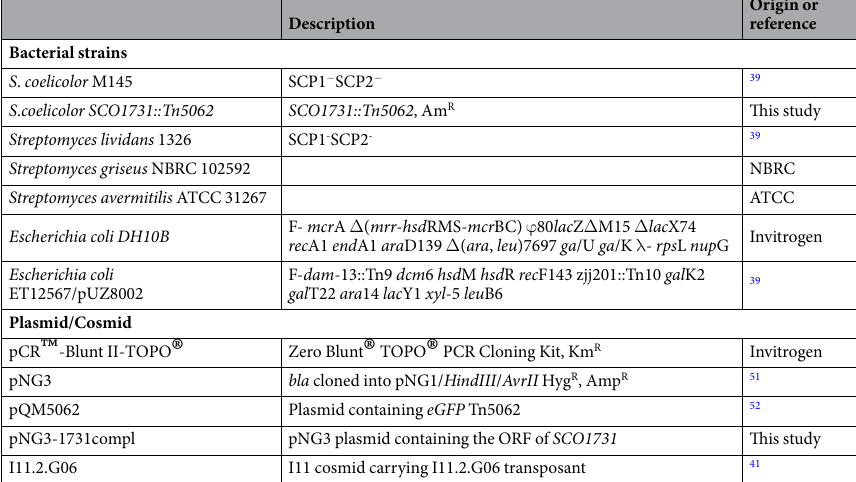
Table 2. Bacterial strains, plasmids and cosmids used in this